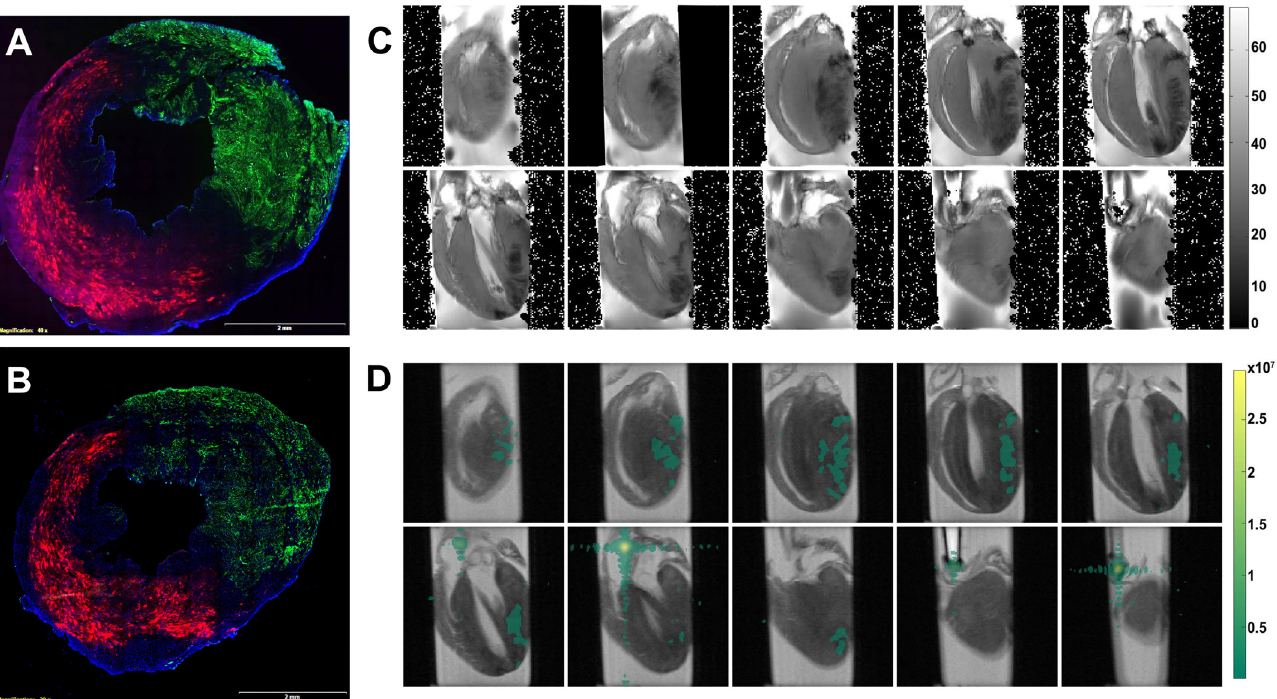
Figure 1. Delivery of perfluorocarbon (PFC) nanoparticles to the area at risk of the heart with ischemia reperfusion injury. ( A-B ) Representative microscopic fluorescent image demonstrates retention of PFC nanoparticles (Red) in the area-at-risk versus none in the normally perfused region (green) as delineated by lectin staining of blood vessels. Representative microscopic fluorescent image from mice 1 h ( A ) and 3 h ( B ) after reperfusion. DAPI was used for nuclei staining (blue). The size of the scale bar was 2 mm, and the magnification was 20×. ( C ) T2-weight MRI reveals edema in the area at risk. ( D ) 19 F MRI (pseudo-colored green) illustrating the colocation of intact PFC nanoparticles with CE-core in regions with ischemia reperfusion injury.